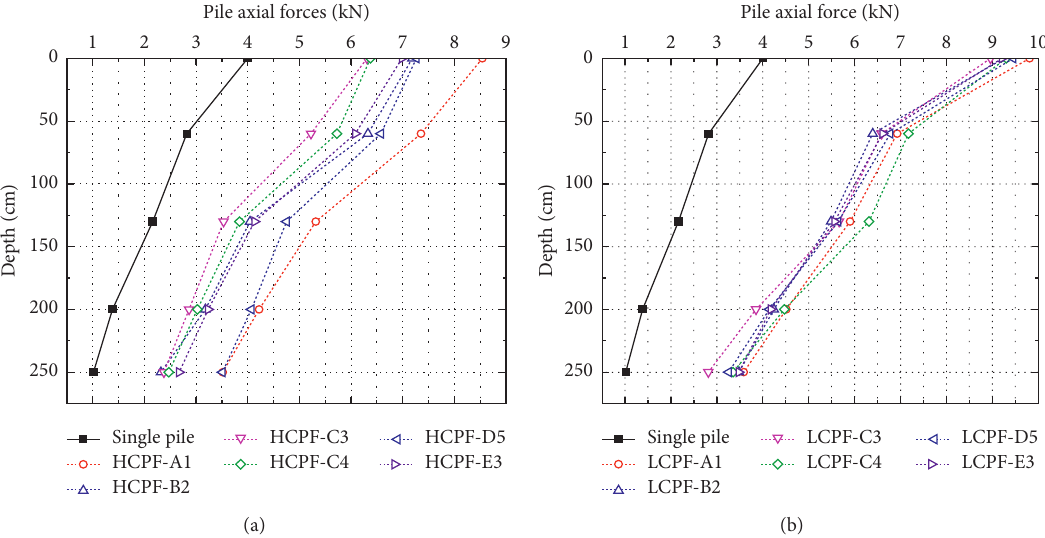
Figure 9: The axial forces of the pile groups and the single pile under the ultimate bearing capacity. (a) HCPF piles and single pile. (b) LCPF piles and single pile.